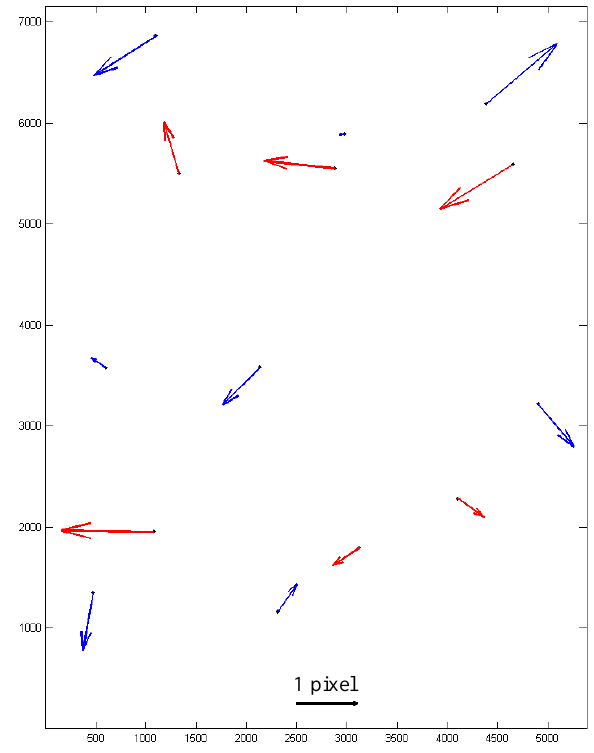
Figure 6. Error vectors for control points (blue) and checkpoints (red) from the feature-based method